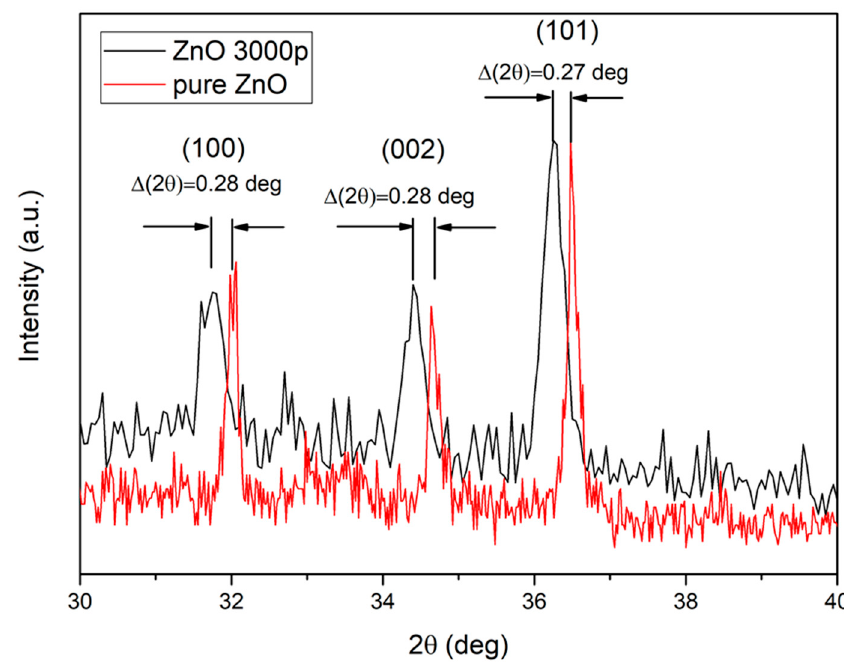
Figure 4. XRD spectrum of ZnO NP (3000 pulses used for Ag deposition in PLD) and reference XRD spectral peaks of ZnO, Ag, AgO and Ag 2 O.